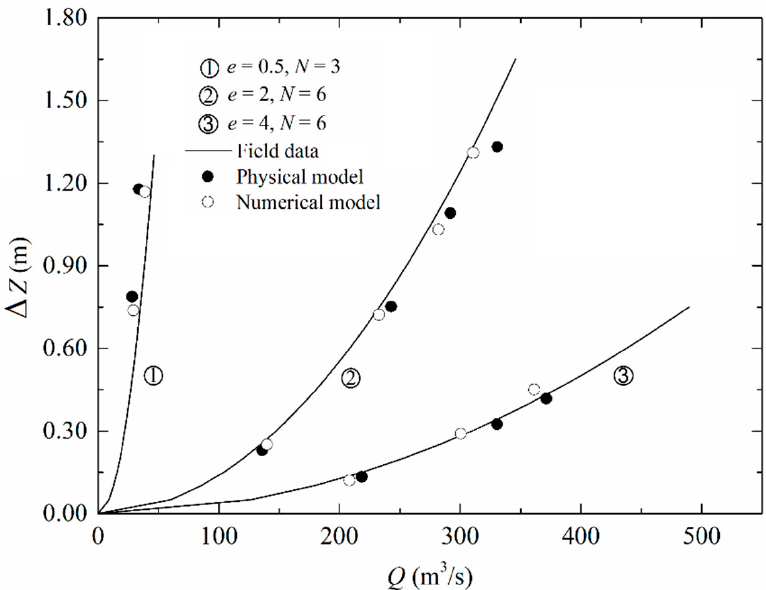
Figure 10. Comparisons of the Q - Δ Z relationship among physical, numerical, and prototype meas- urement results.